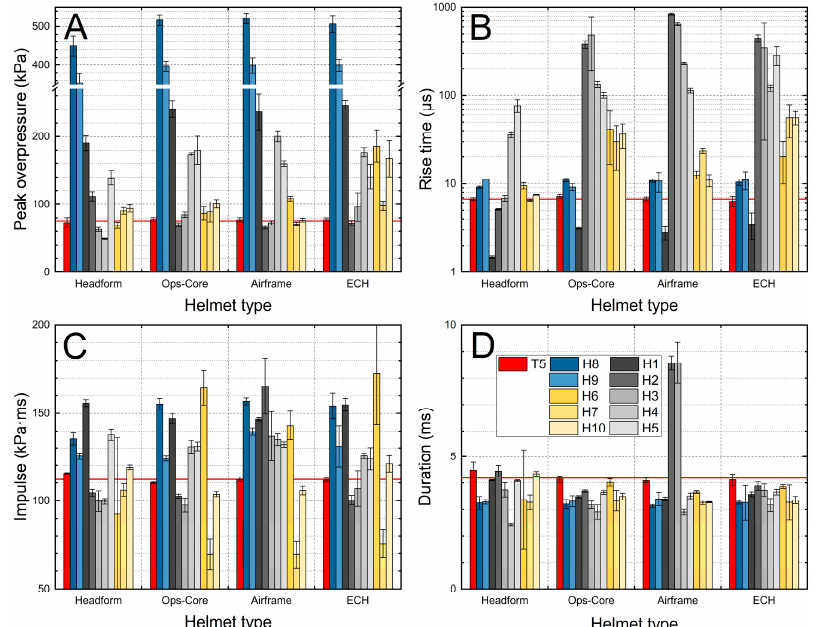
Figure 6. The quantification of peak overpressure ( A ), rise time ( B ), impulse ( C ), and duration ( D ) recorded for a nominal BOP of 70 kPa. The headform with no helmet (Headform), or equipped with the Ops-Core, Airframe, or ECH helmets were used to measure surface pressure distribution at a nominal shock wave intensity of 70 kPa.